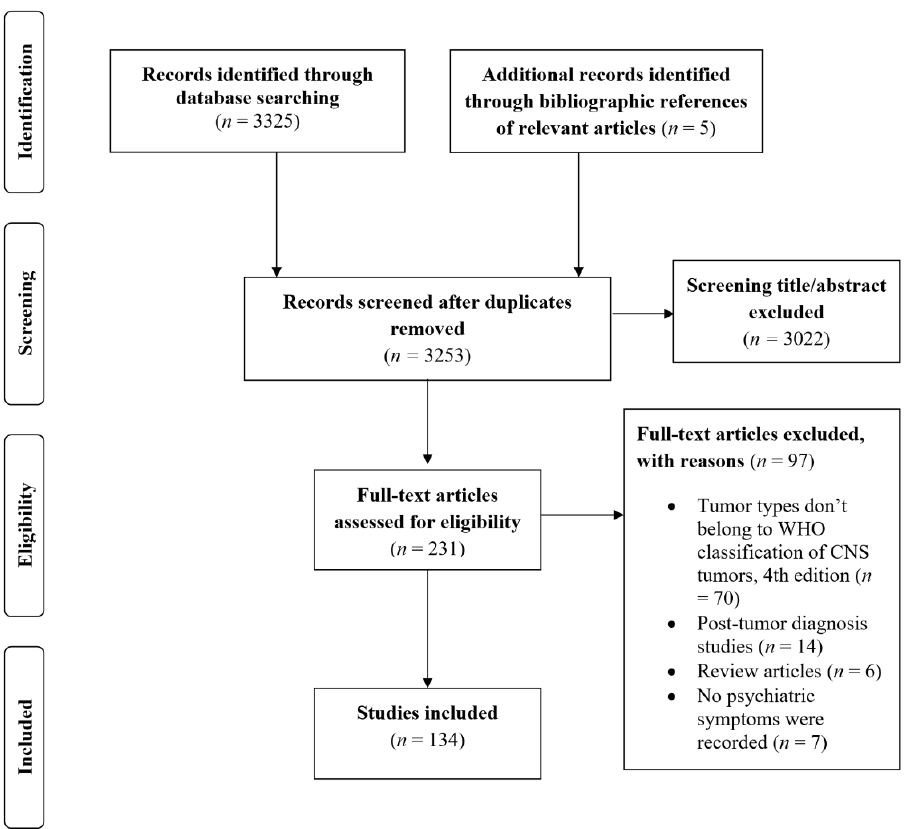
Figure 1. Flow chart showing the selection process of studies.